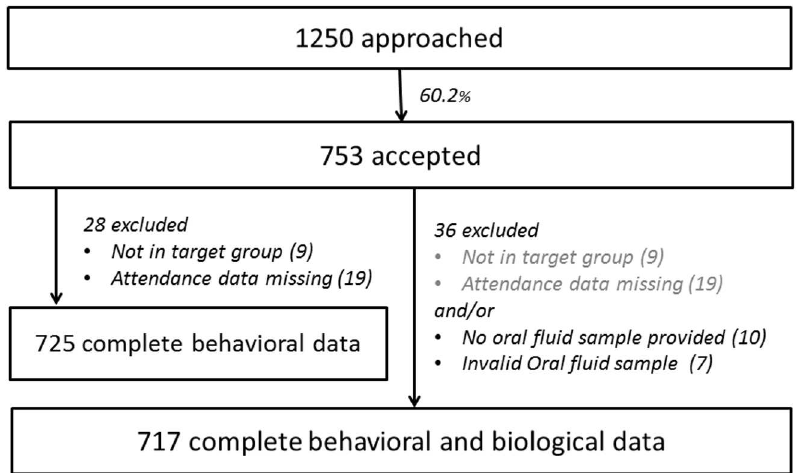
Fig 1. Flowchart of cases included in the unweighted and weighted analysis, generating respectively sample- and population